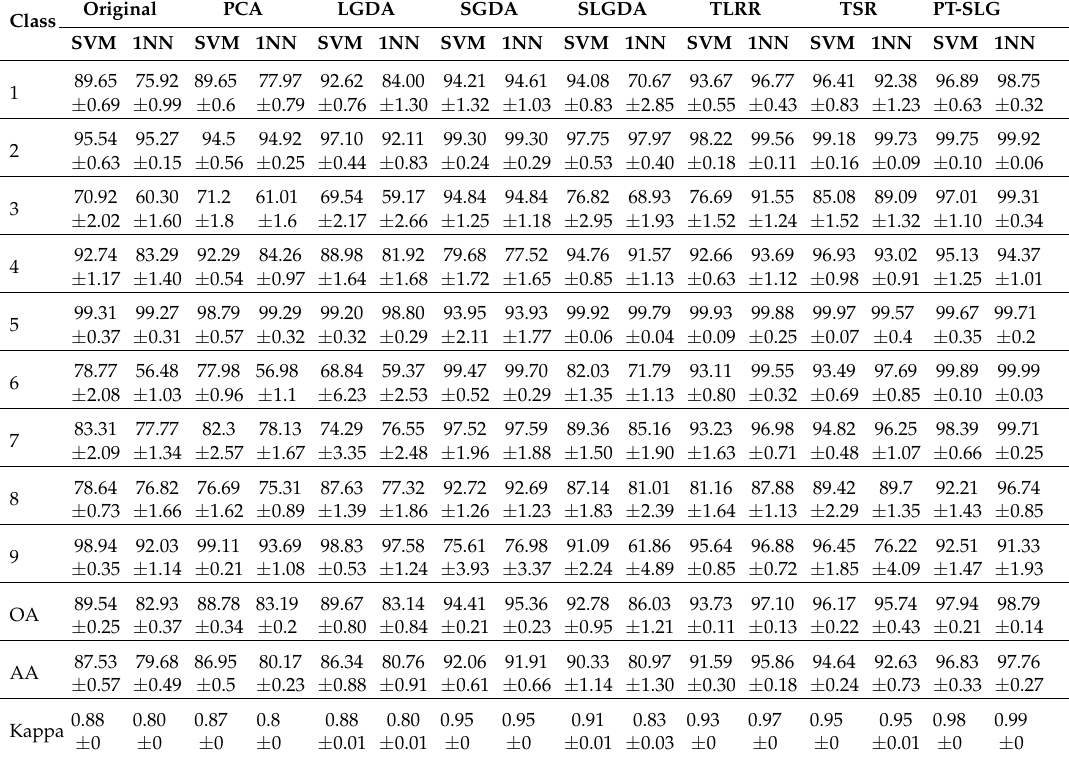
Table 2. Classification results on Pavia University dataset (reduction dimensionality =